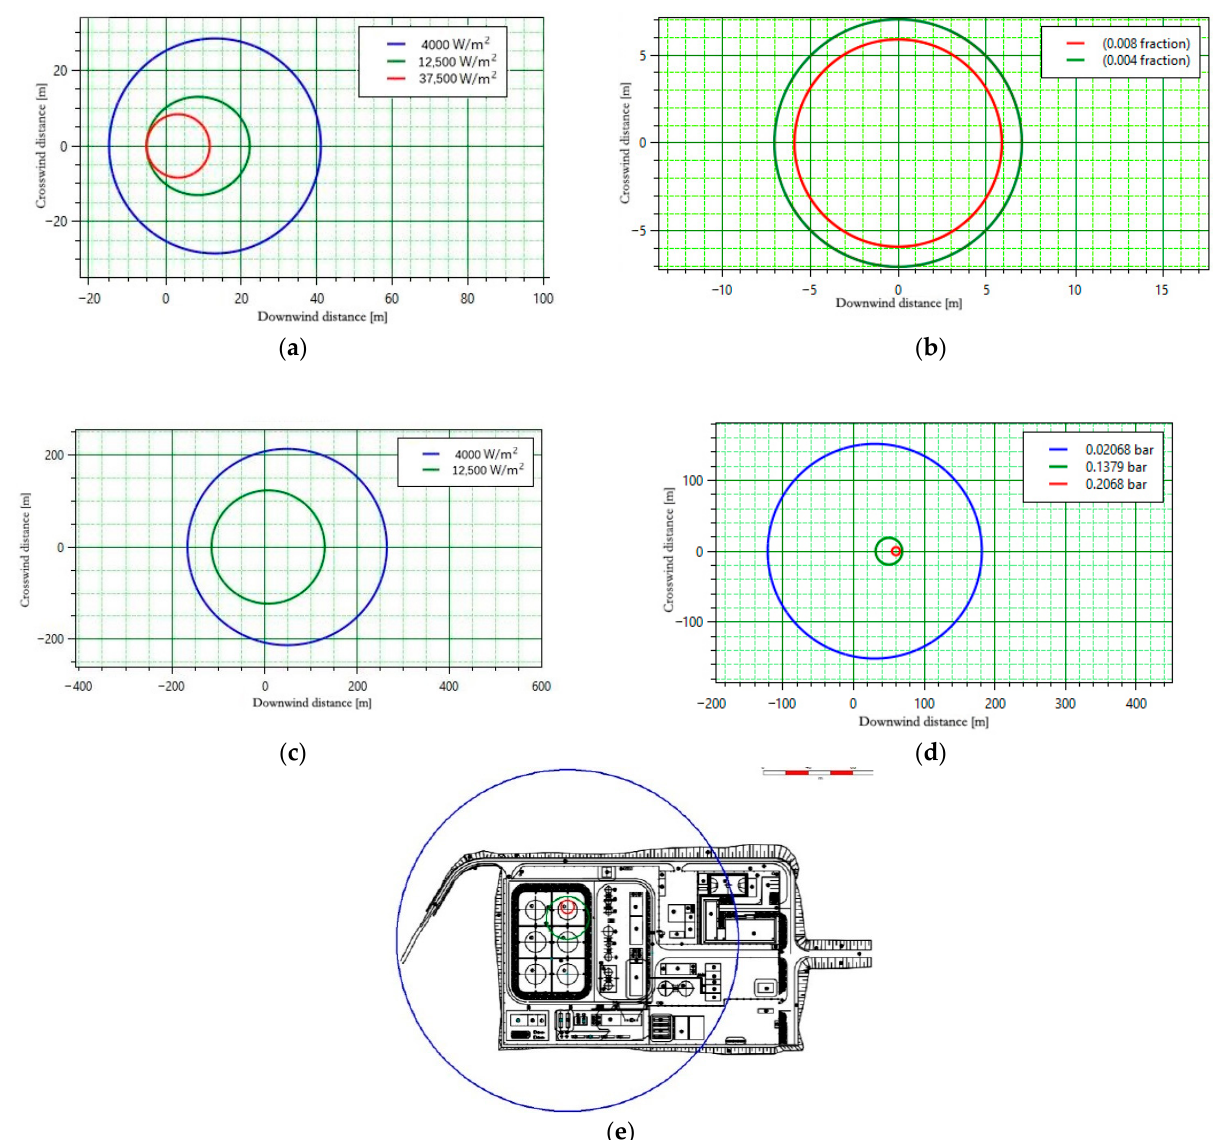
Figure 7. ( a ) Pool fire with small aperture leakage; ( b ) flash fire with medium aperture leakage; ( c ) pool fire with large aperture leakage; ( d ) vapor cloud explosion with complete rupture; ( e ) vapor cloud explosion damage radius marked on the station graphic layout.